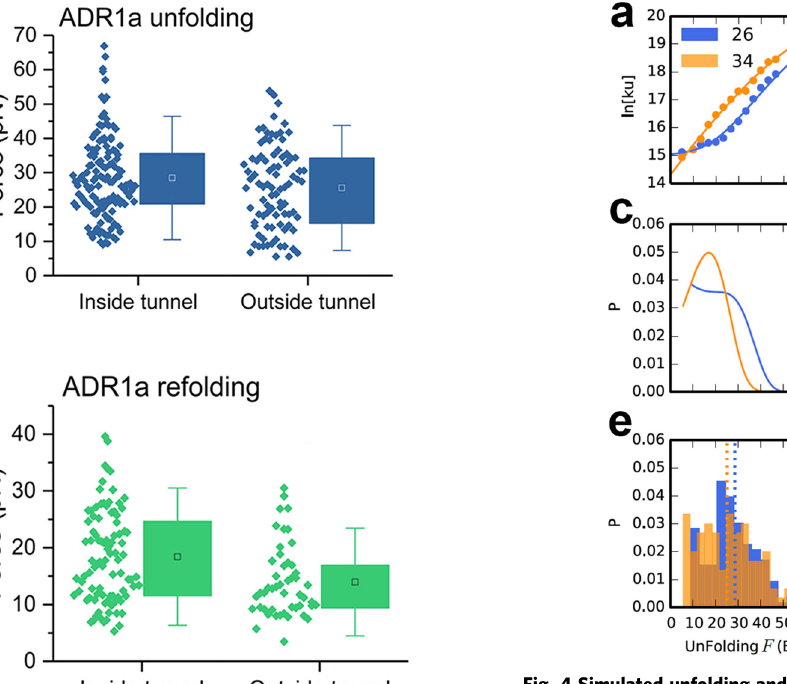
(Fig. 5b and Supplementary Data 7), using the equation 4 G ¼ 4 E (cid:2) T 4 S , where 4 E and 4 S represent the energy and